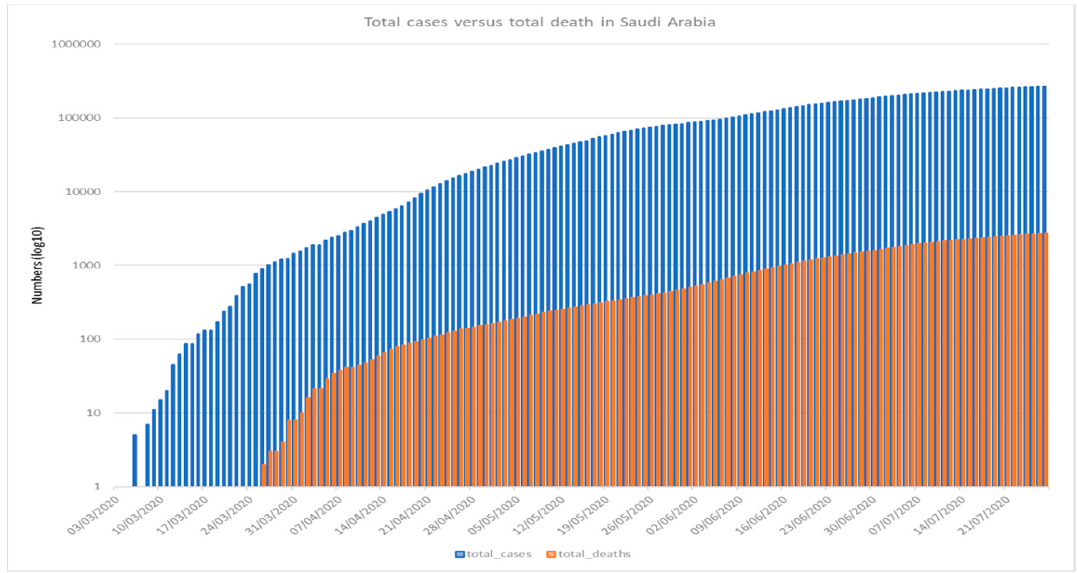
Figure 3. COVID-19 total recorded cases versus total death in Saudi Arabia recorded for COVID-19 from 3 March–21 July 2020 ( Using logarithmic scale based 10 ).